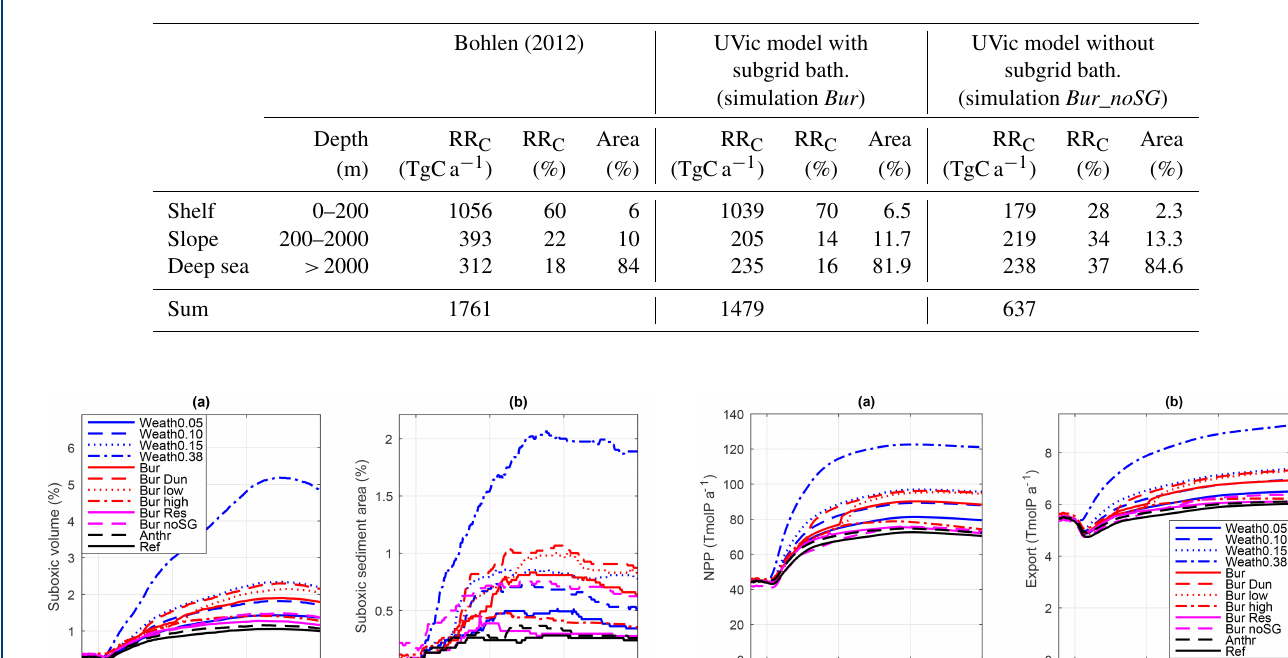
Table 2. Rain rate of particulate organic carbon (RR C ) to the seafloor for the shelf, slope and deep-sea areas from the observational estimate by Bohlen et al. (2012) and for the UVic model simulation ( Bur ) with and without subgrid bathymetry. Pre-industrial RR C shows no significant differences among all model simulations (expect for simulation Bur_noSG ).